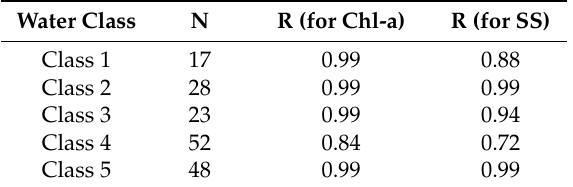
Table 4. Class-specific correlation coefficient values for neural network based Chl-a and SS